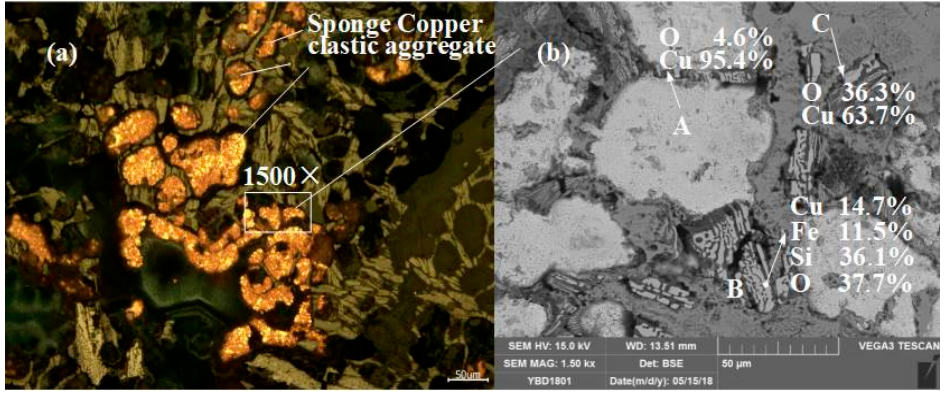
Figure 24. Optical micrograph ( a ) and SEM backsca tt ered electron image ( b ) of YBD18.